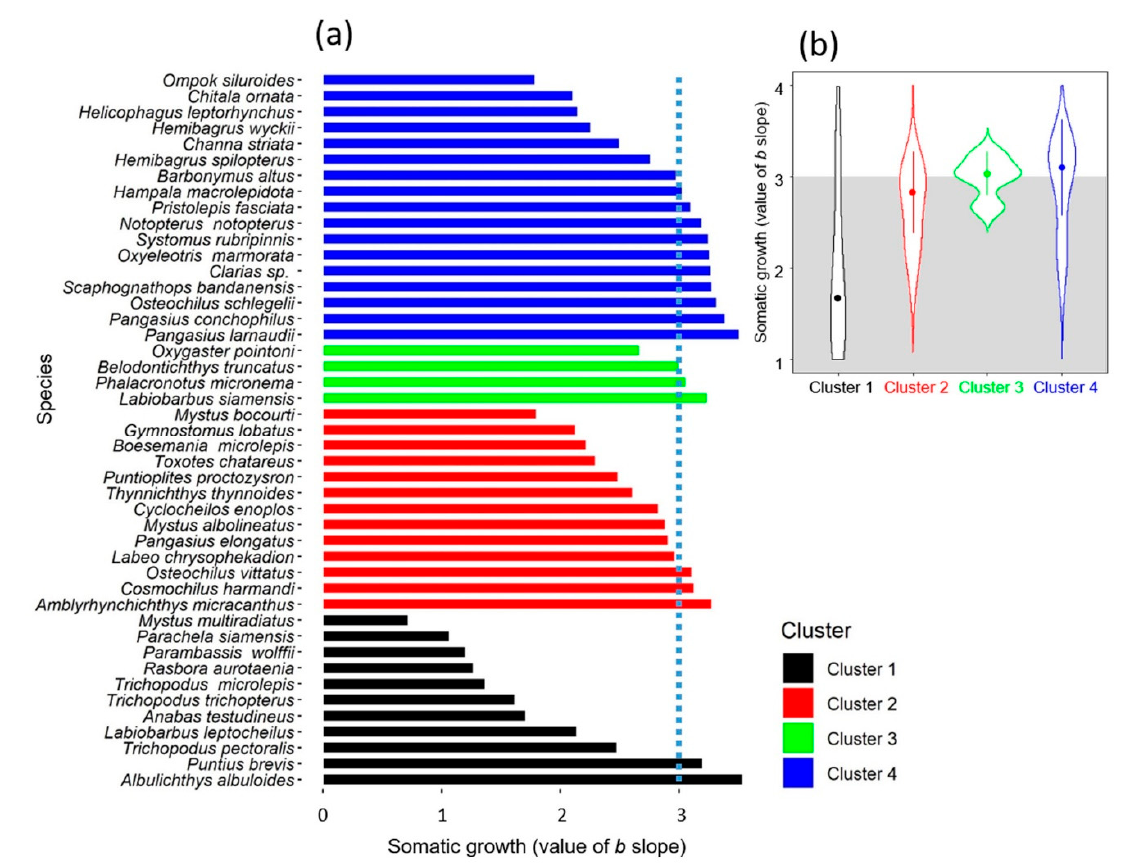
Figure 5. Fish growth conditions, determined by regression coefficient values (slope b ) of the length–weight linear models for 45 indicator species characterizing freshwater fish assemblages in Cambodia inland water bodies: ( a ) regression coefficient values (slope b ) by indicator species: isometric growth ( b = 3), positive allometric growth ( b > 3) or negative allometric growth ( b < 3). ( b ) violin plots summarizing regression coefficients of the length–weight linear relationship by fish assemblage cluster. Area above the grey shaded area denotes regression coefficient values b > 3, positive allometric growth.